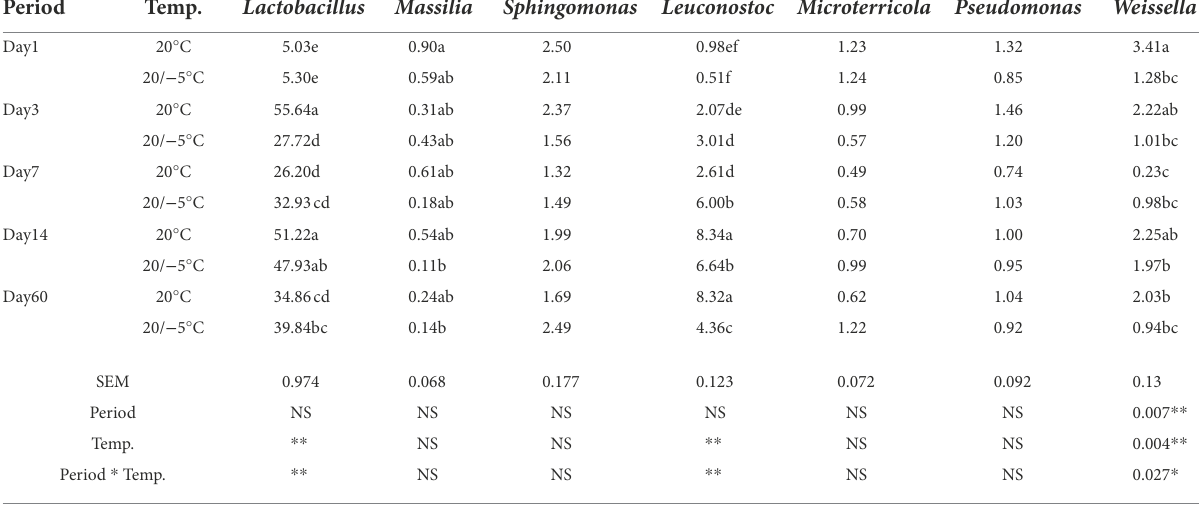
TABLE 3 Relative abundances of seven most abundant bacterial genera (%).